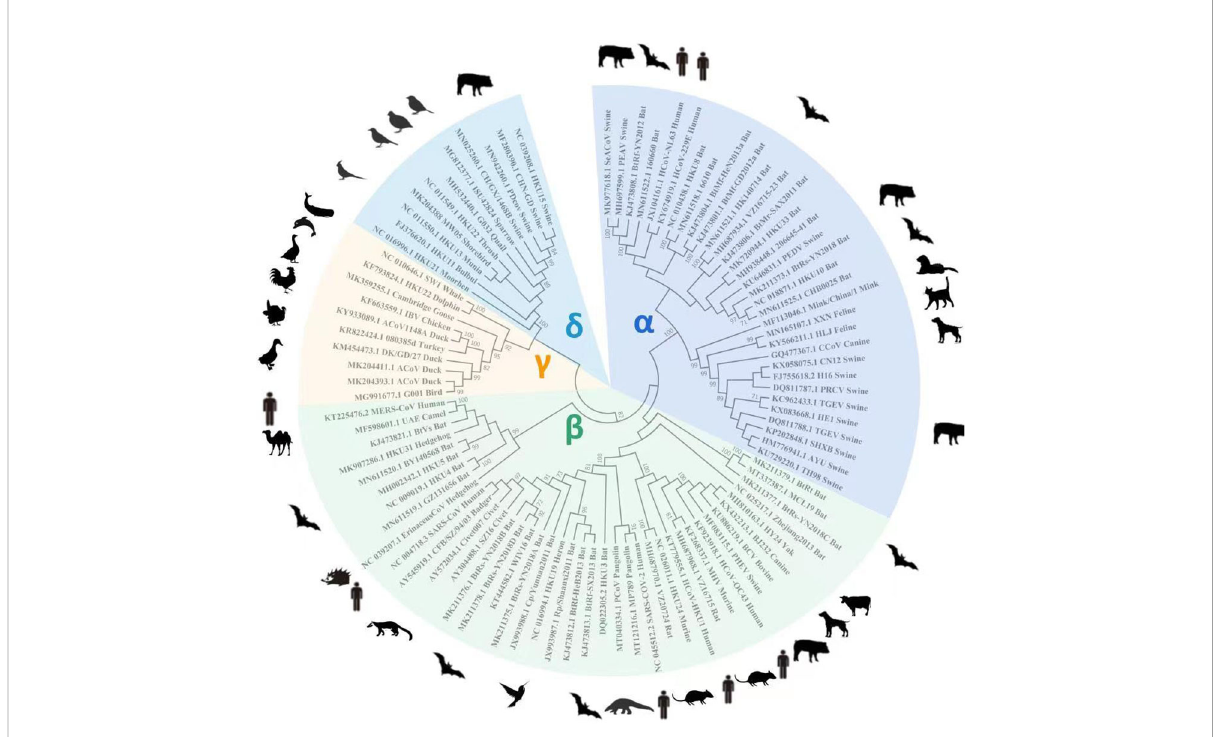
FIGURE 1 For RdRp gene homology analysis, 93 known RdRp gene amino acid sequences were retrieved from the NCBI database to construct a phylogenetic tree using Mega X software. The tree shows alpha and beta CoVs genera had the highest RdRp amino acid sequence homology, followed by gamma and delta